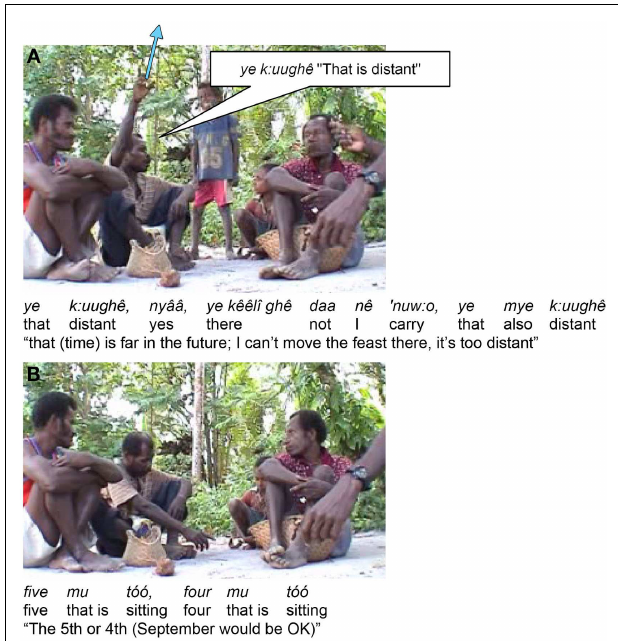
FIGURE 7 |Time line from high (distant future) depicted in (A), to low (near future) in (B).